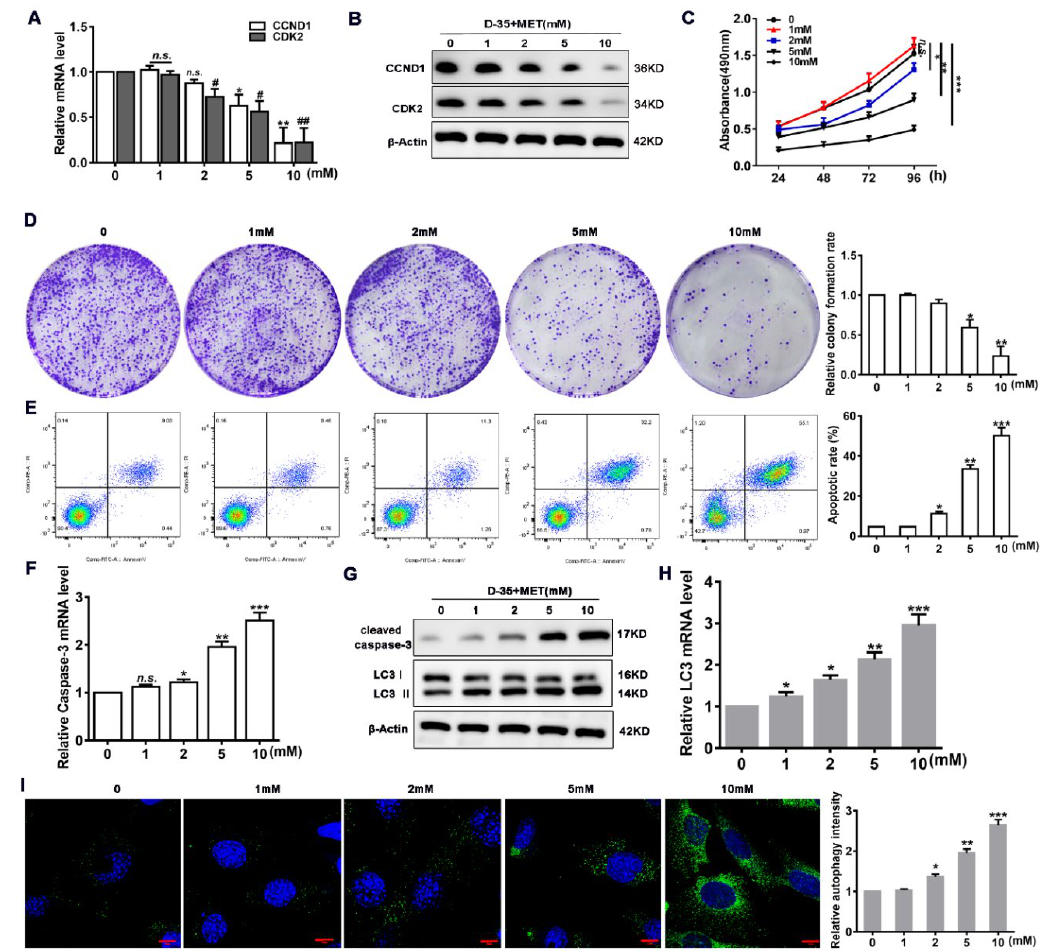
Figure 2. Diane-35 and metformin promote apoptosis and autophagy in EC cells. Human endometrial carcinoma (Ishikawa) cells were treated with increasing concentrations of Diane-35 and metformin (0, 1, 2, 5, and 10 mM) for 24 h. Then, qRT-PCR ( A ) and Western blot ( B ) analyses were used to assess cell proliferation genes CCND1and CDK2 and protein expression. CCK-8 ( C ) and colony formation assay ( D ) were used to evaluate proliferation, and flow cytometry ( E ) was performed to assess apoptosis. Apoptotic biomarker, cleaved caspase-3, was assessed by qRT-PCR ( F ) and Western blot ( G ) analyses. Cell autophagic markers were assessed by qRT-PCR ( H ), Western blotting ( G ), and immunofluorescence staining for LC3 (green) and DAPI (blue) ( I ). Data are shown as the mean ±